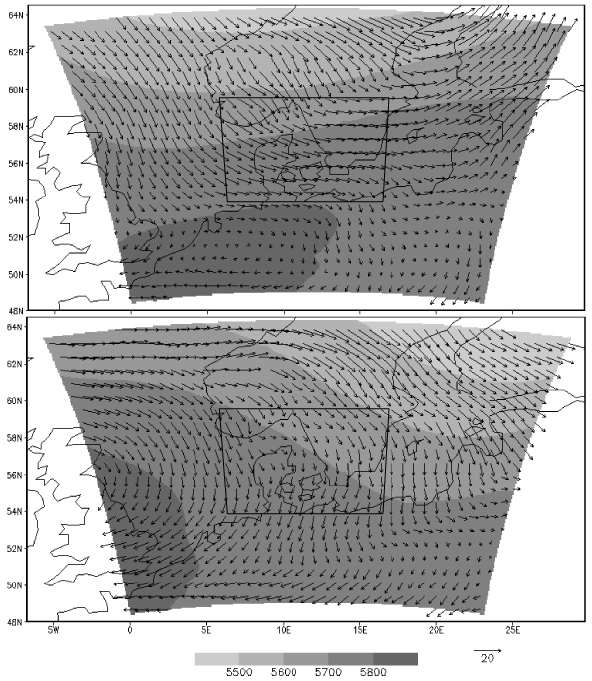
Fig. 3. WRF model outer grid geopotential height at 500hPa (grey colors) and 850hPa wind vectors (arrows) at 00:00UTC, 16 Octo- ber (top) and 00:00UTC, 17 October (bottom). The shaded regions in both panels indicate the extension of the inner